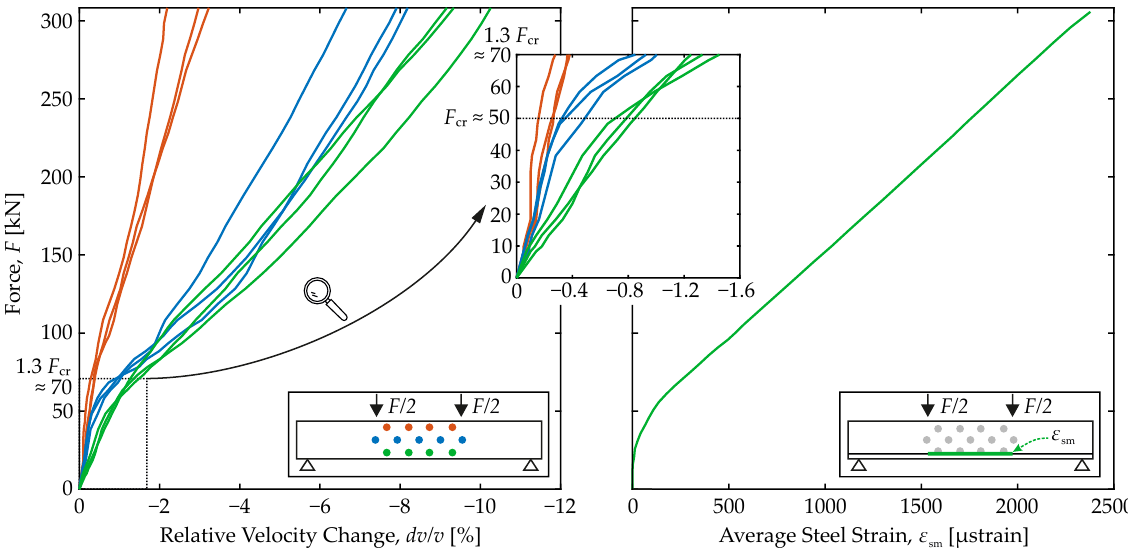
Figure 7. Load of the specimen plotted versus the relative velocity change ( left ) with particular focus on the non-cracked (cid:192) and cracking (cid:193) range and average steel strain ( right ). Moreover, uncertain onset of cracking, load-dependent crack growth, as well as the variable compressive and tensile zone heights, cause these proportions to vary with time and load. Different sensitivity to tensile and compressive strains in general and with respect to the material state, cracked or non-cracked, is another factor that affects the magnitude of the relative velocity